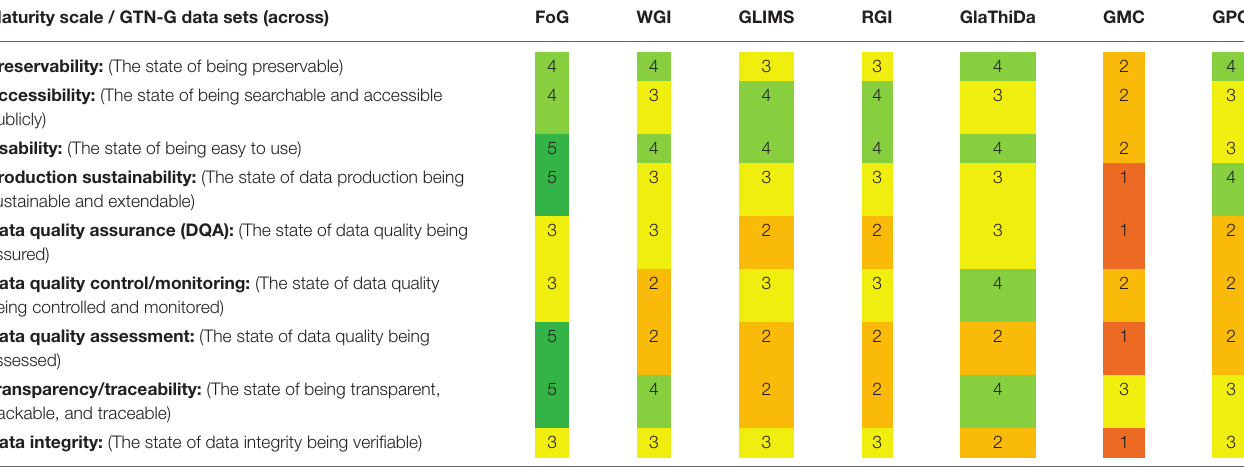
TABLE 2 | Summary matrix with the performance of the seven datasets available within GTN-G. Maturity scale / GTN-G data sets (across) FoG WGI GLIMS RGI GlaThiDa GMC GPC